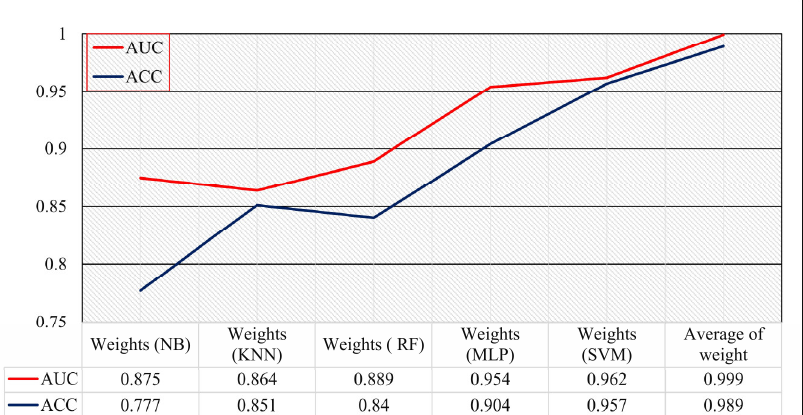
Figure 14. A comparative evaluation of the WSR classifications produced by the W.L.C technique in GIS using criteria weights extracted by the five models.